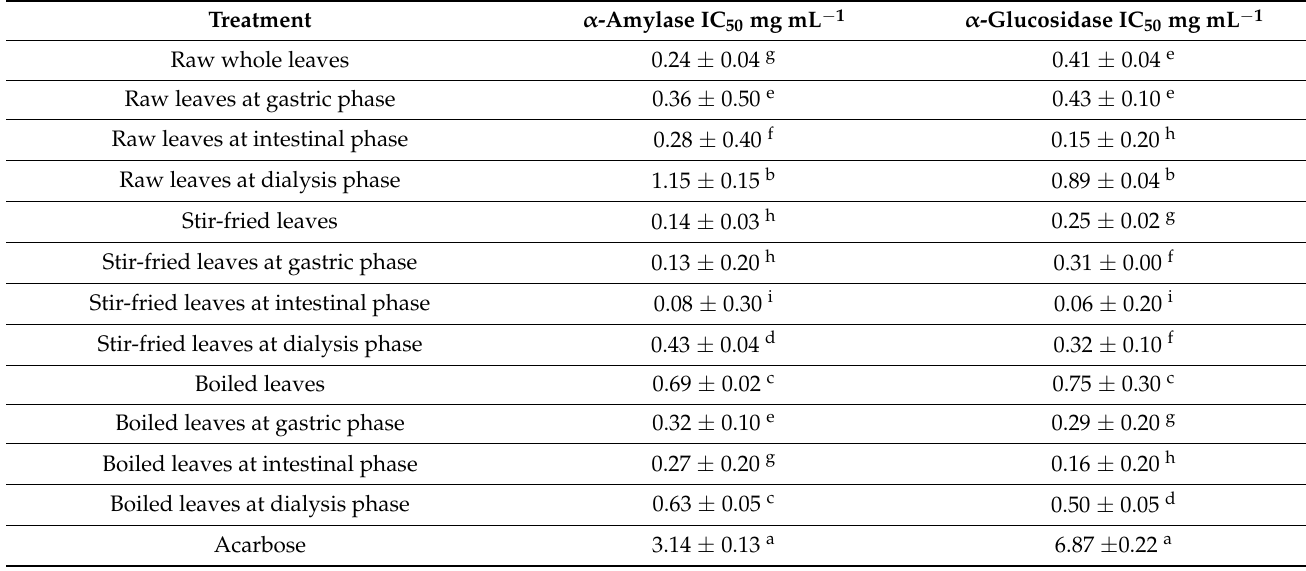
Table 2. Effects of household cooking methods and simulated gastrointestinal digestion on the inhibitory effect of African pumpkin leaves ( Momordica balsamina L.) on carbohydrate hydrolysing